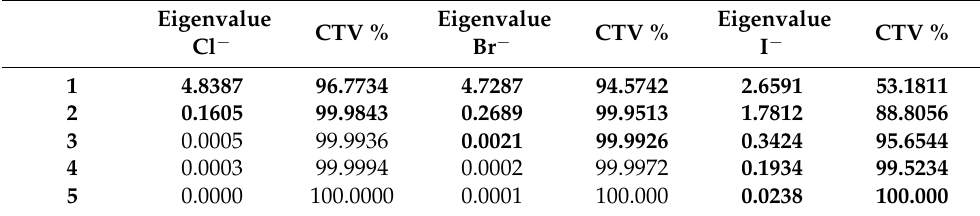
Figure 3. The dependence of molar absorption coefficient of Tl(III)–PAR complex on halide concentration measured at 520 nm (see examples in Figure 2). The open symbols are for Tl(III)–PAR complex in 1:1 ratio, the full symbols for Tl(III)–PAR complex in 1:2 ratio, the circle symbols are for iodide, the rectangle symbols are for bromide and the triangle symbols are for chloride. Table 1. The results of PCA analysis of absorption spectra for selected wavelengths. (400, 450, 500, 520, 550, 600, 650 nm) (see Figure 2). The bold numbers mean the number of light-absorbing species in solution estimated according to